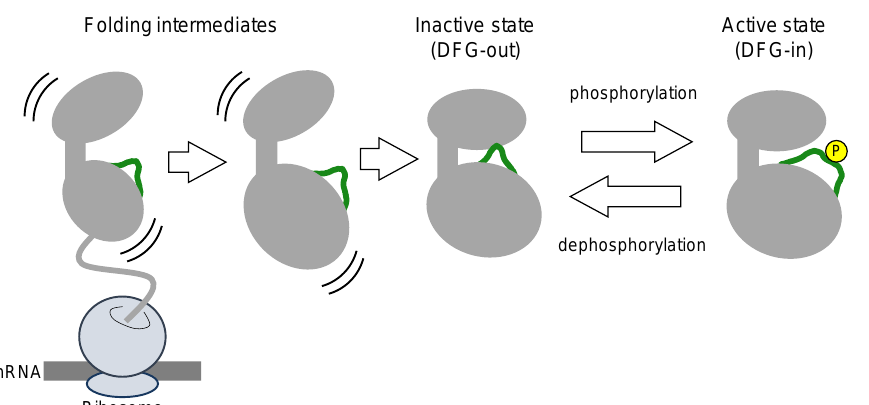
Figure 2. The co-translational folding process of the kinase domain and subsequent activation by phosphorylation (yellow) of the activation loop (green). The nascent polypeptide on the ribosome is folded into its intermediate state. Folding intermediates are unstable and exhibit structural fluctuations in thermodynamic equilibrium. Once the activation loop is phosphorylated, the intermediate state is converted to the active DFG-in state, which returns to the inactive DFG-out state after dephosphorylation by phosphatases.